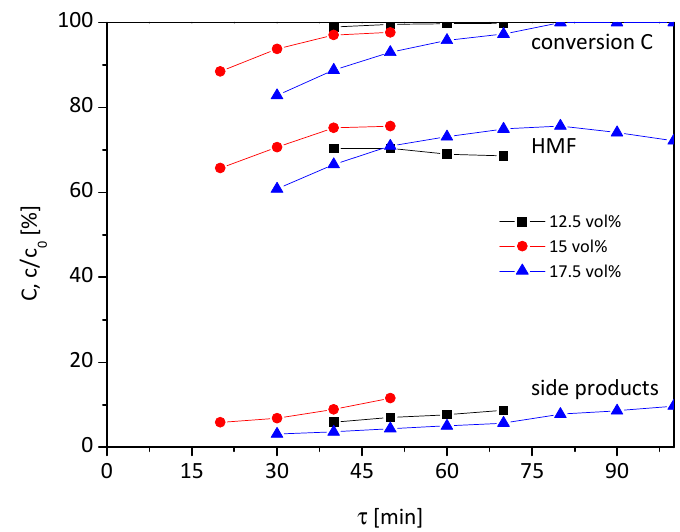
Figure 2. Influence of water content on conversion, HMF yield and by-products (0.1 M fructose, 95 °C, 12.5–17.5 vol% H 2 O in HFIP, 1.7 g Lewatit K2420 catalyst bed).